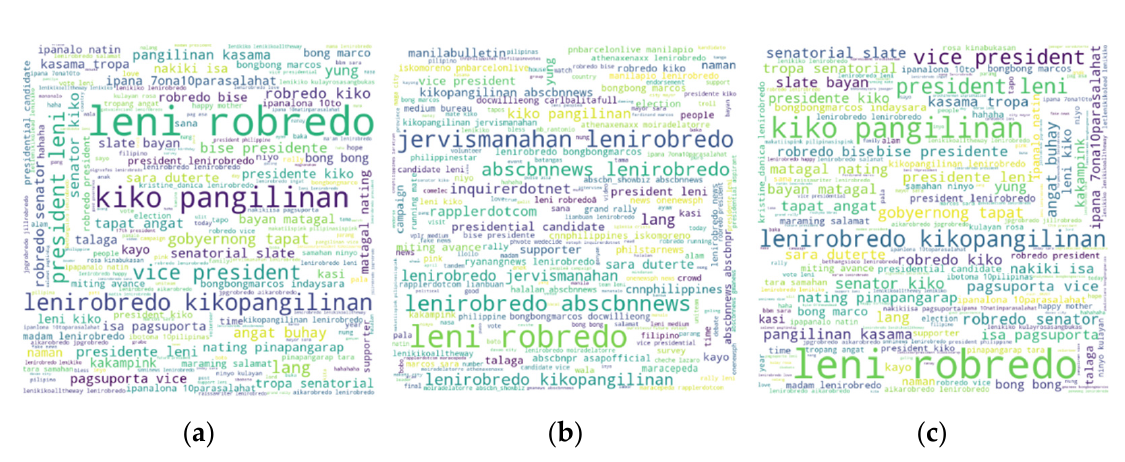
Figure 4. Generated word cloud representing the following polarities: ( a ) positive, ( b ) neutral, and ( c ) negative. The word cloud displays the words used in the dataset; the more frequently the word was used, the bigger it is displayed in the word cloud.